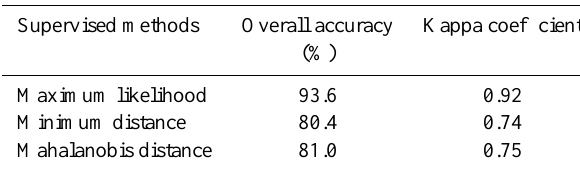
Table 1. Overall accuracy and kappa coefficient ∗ for the ground truth set associated with each supervised method tested.